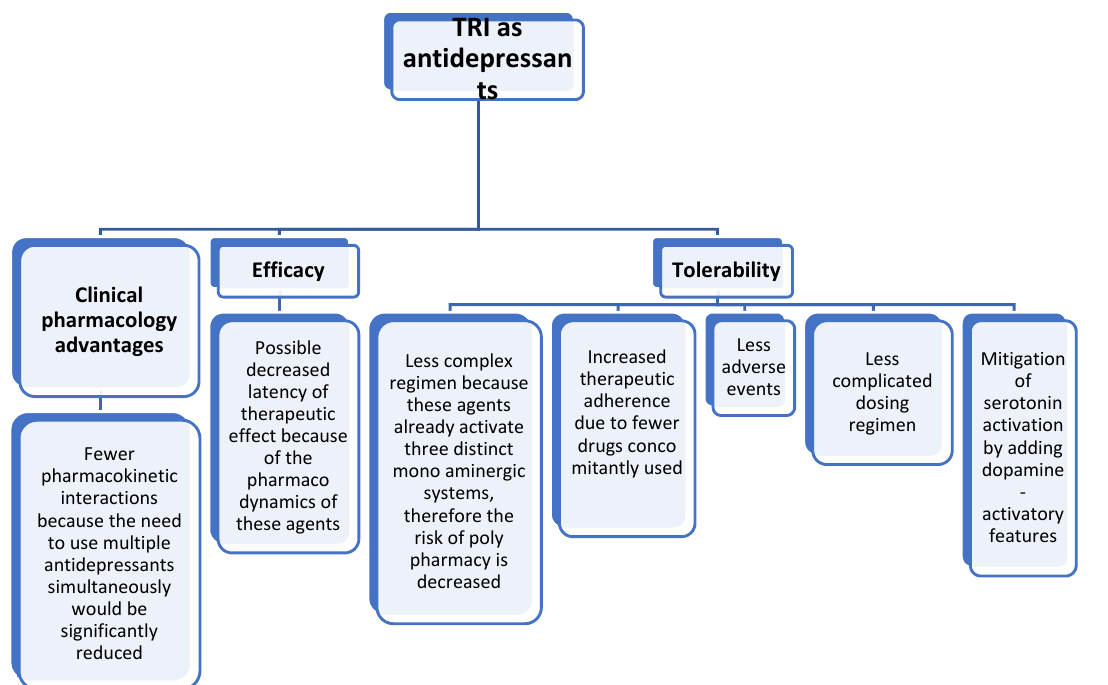
Figure 2. Potential benefits of TRI as antidepressants use in clinical practice.